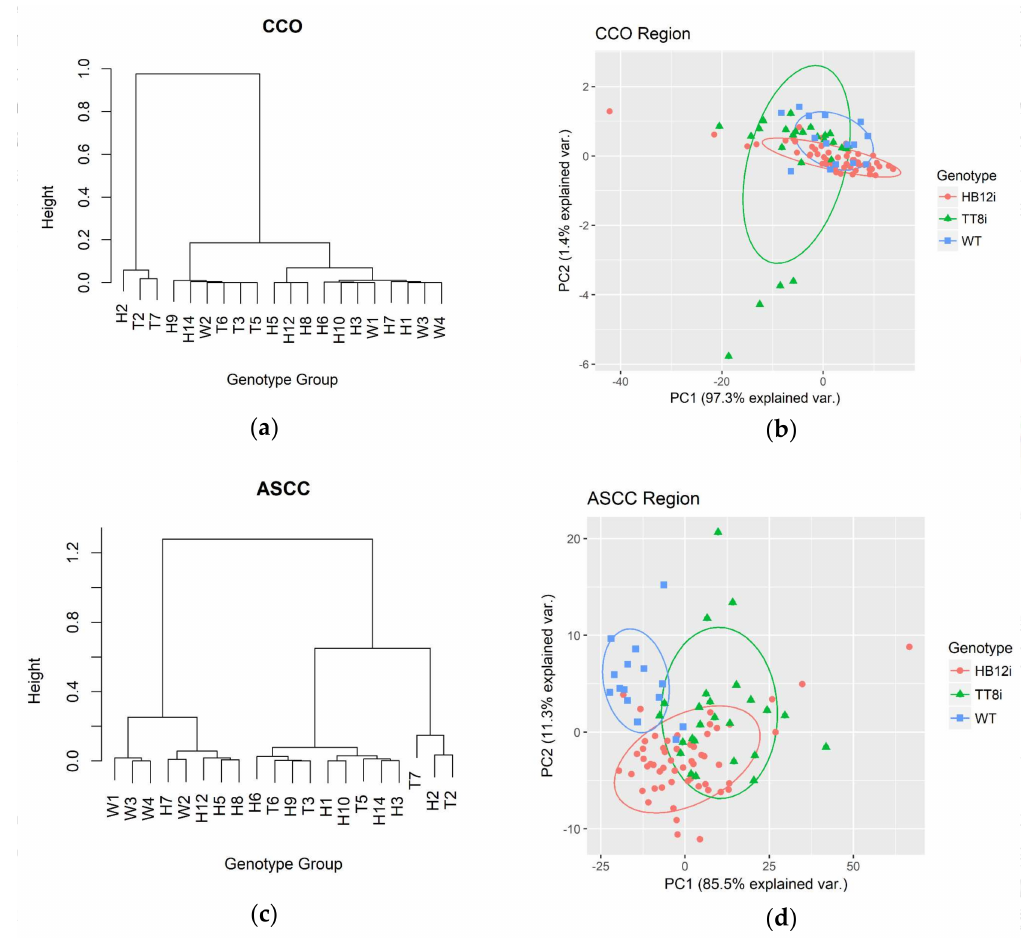
Figure 3. Hierarchy cluster analysis (HCA) dendrograms and principle component analysis (PCA) plots of lipid-related region of transgenic (H1–H3, H5–H10, H12, H14; T2–T3, T5–T7) and WT (W1–W4) control. CCO, carbonyl C=O region (ca. 1710–1781 cm − 1 ); ASCC, asymmetric and symmetric CH2 and CH3 region (ca 3000–2761 cm − 1 ). ( a ) HCA dendrogram of CCO region; ( b ) PCA plot of CCO region; ( c ) HCA dendrogram of ASCC region; ( d ) PCA plot of ASCC region.